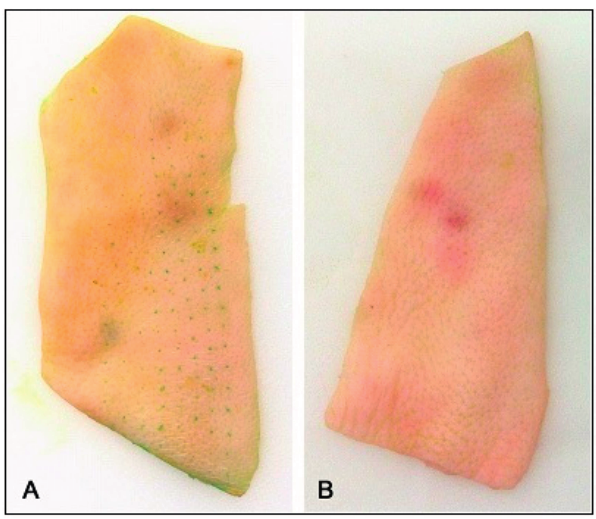
Figure 2. Microchannel visualization using margin marking dye. ( A ) Porcine skin treated with microneedle roller. ( B ) Non-treated porcine skin as the control.